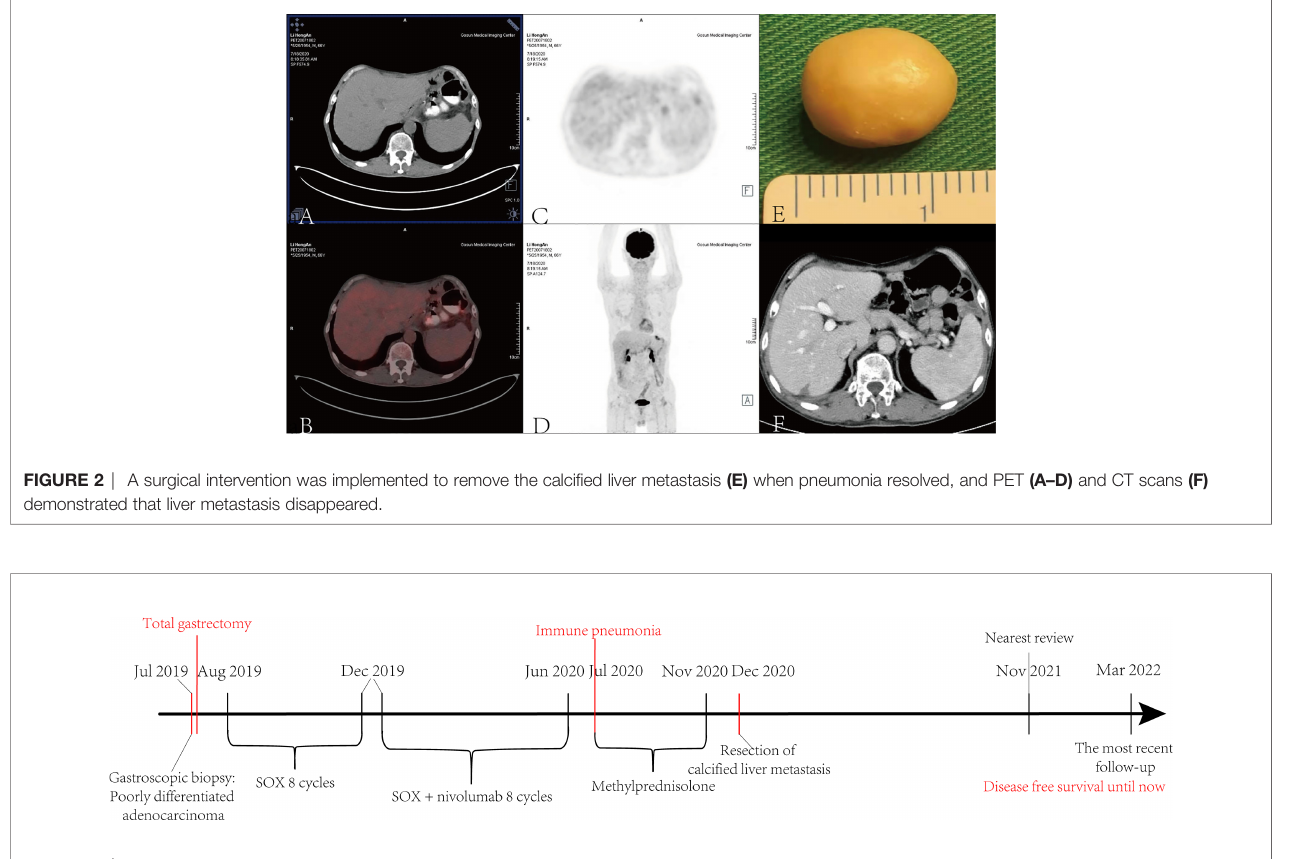
FIGURE 3 | The course timeline showed that shortly after the diagnosis of advanced gastric cancer, the patient underwent total gastrectomy for acute gastric bleeding, followed by eight cycles of SOX and then eight cycles of SOX + nivolumab treatment. Subsequently, immune pneumonia occurred and was treated with methylprednisolone. After the patient became stable, the suspected calci fi ed metastasis of the liver was removed, and all medications were stopped. The patient has achieved disease-free survival until now.